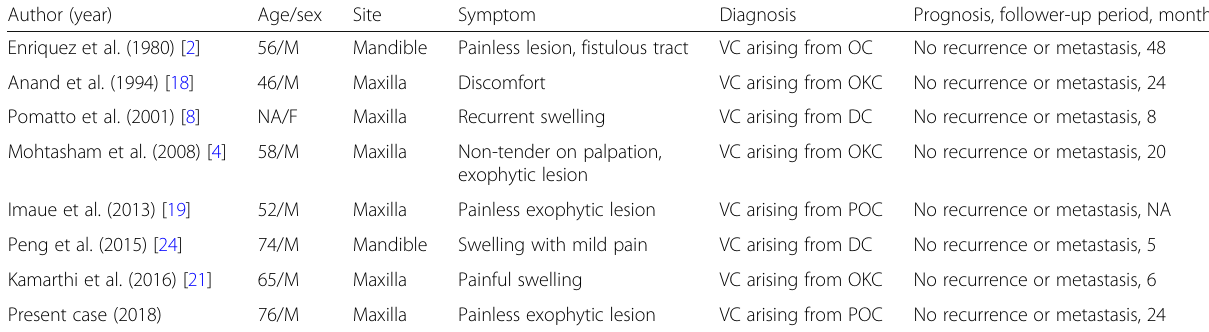
Table 1 Reported cases of verrucous carcinoma arising from odontogenic cystic lesion Author